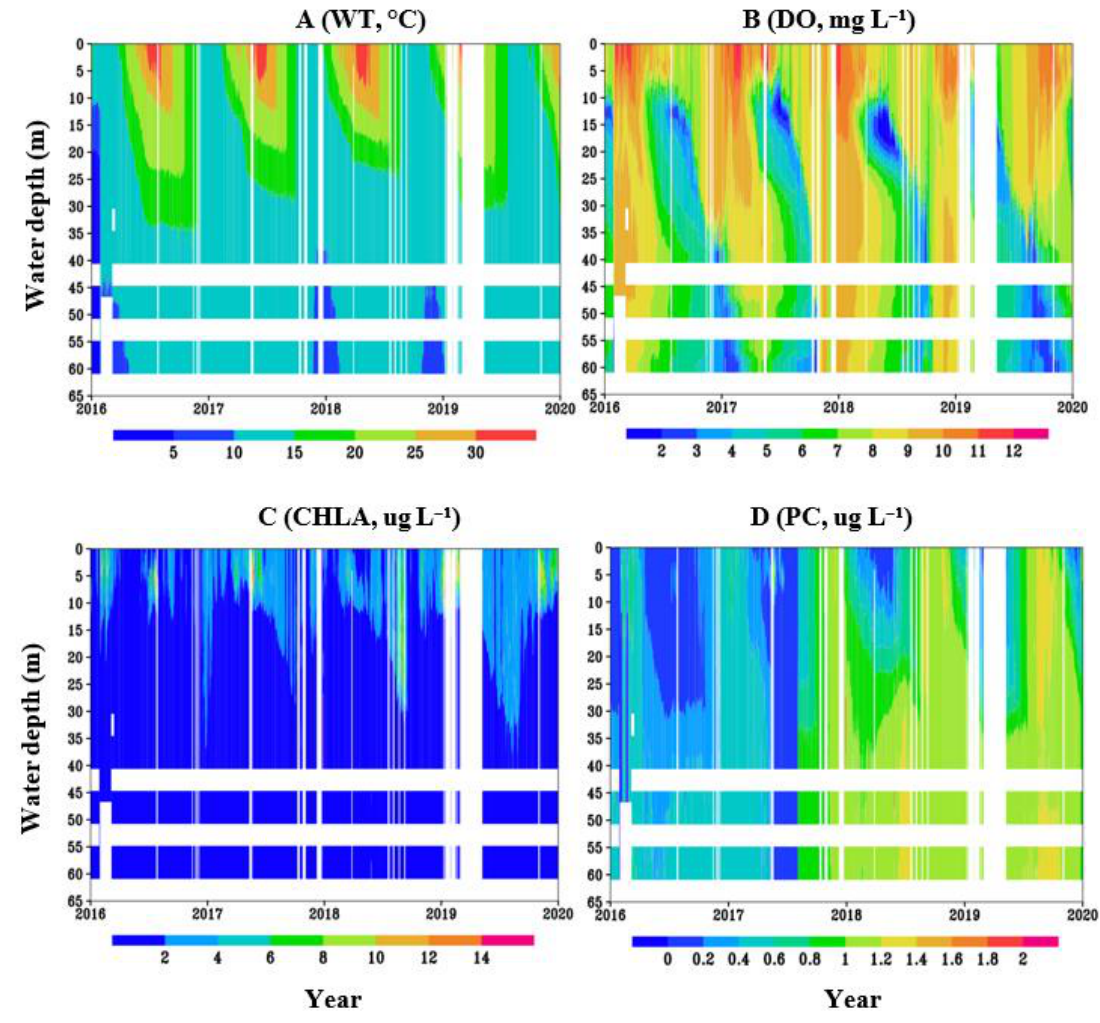
Figure 4. Daily ( A )WT, ( B ) DO, ( C ) CHLA and ( D ) PC profiles at site 4 for 1 January 2016 – 10 July 2020. Y-axes for ( A – D ) represent water depth (m) and X-axes represent years from 2016 to 2020. White areas denote lack of measurements. Table 4. Threshold of WQ parameters required for Lake Qiandao.